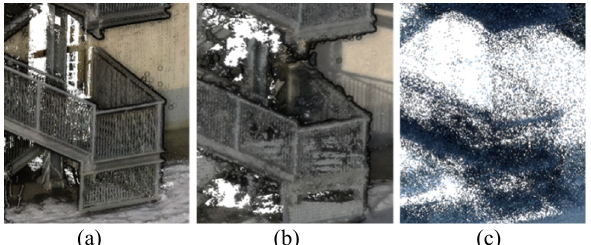
Figure 13. Emergency stairs detail on the south façade.